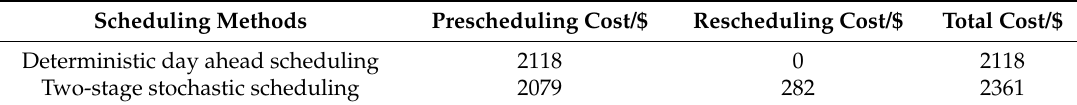
Table 1. Impact of different dispatch approaches on the operating costs